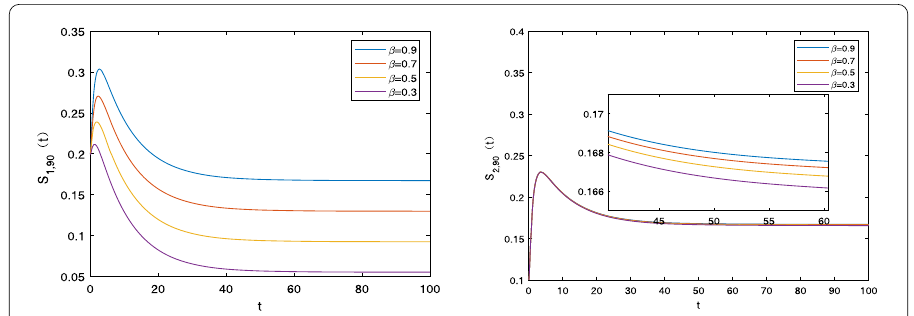
Figure 6 The densities of S 1,90 ( t ) and S 2,90 ( t ) with different values of β